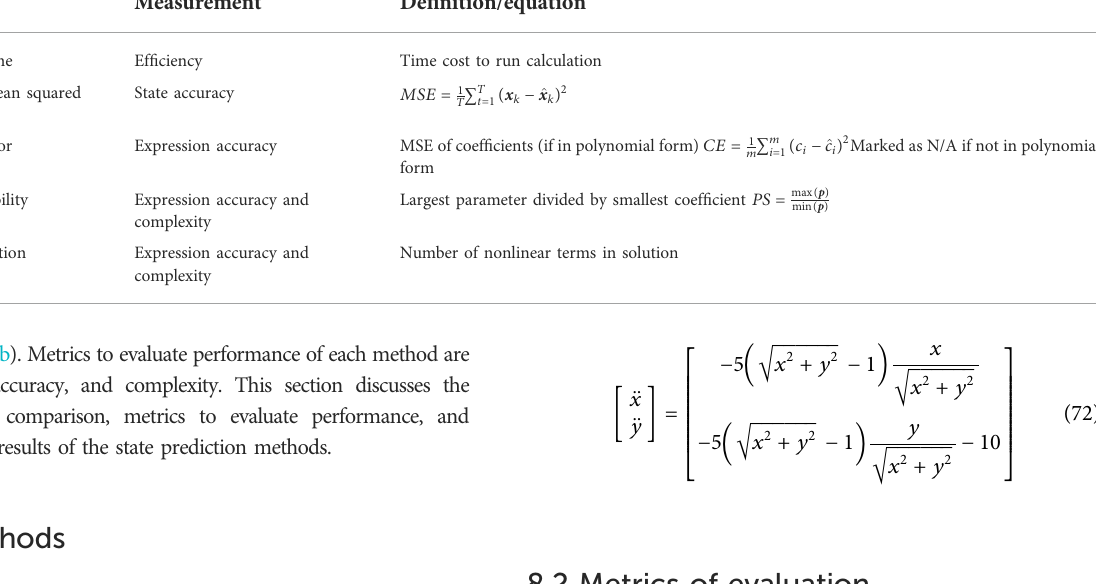
TABLE 2 Metrics for evaluating system identi fi cation methods on dynamic systems.